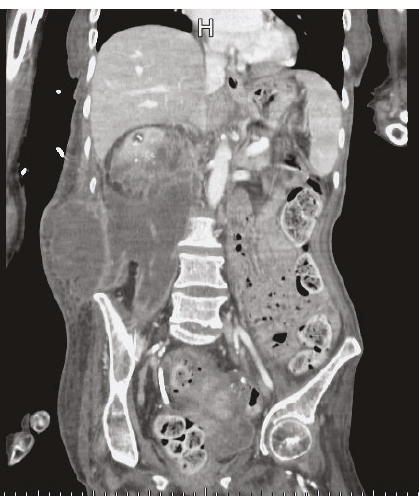
Figure 3: Coronal section of a CT scan if the abdomen/pelvis with IV contrast revealing severe hydronephrotic right kidney with accompany urinoma in the